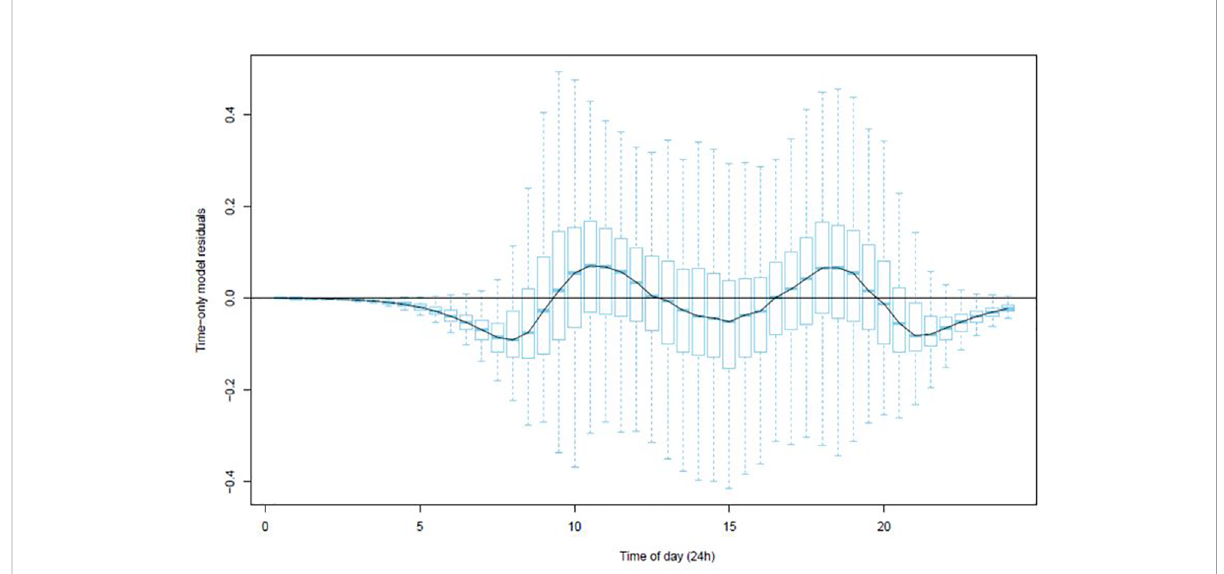
FIGURE 2 Boxplot of the residuals from the time-only model (Equation 1) at each 30-minute